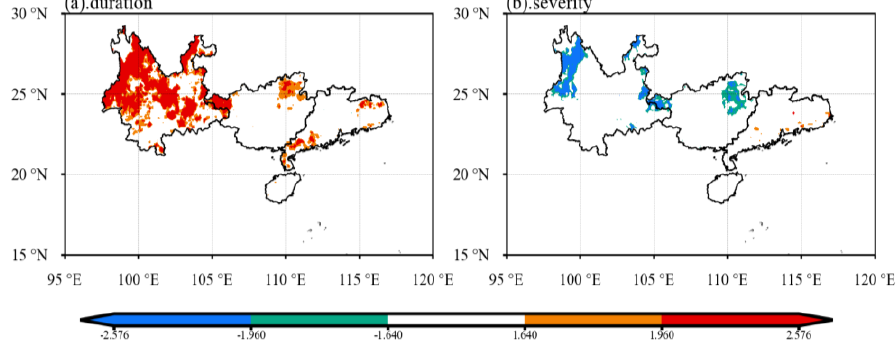
Figure 7. Mann–Kendall trends of drought duration ( a ) and drought severity ( b ) for 1981–2020. Values larger than 1.96 or smaller than − 1.96 pass the 0.05 significance test level, while values larger than 1.64 or smaller than − 1.64 pass the 0.1 significance test level.